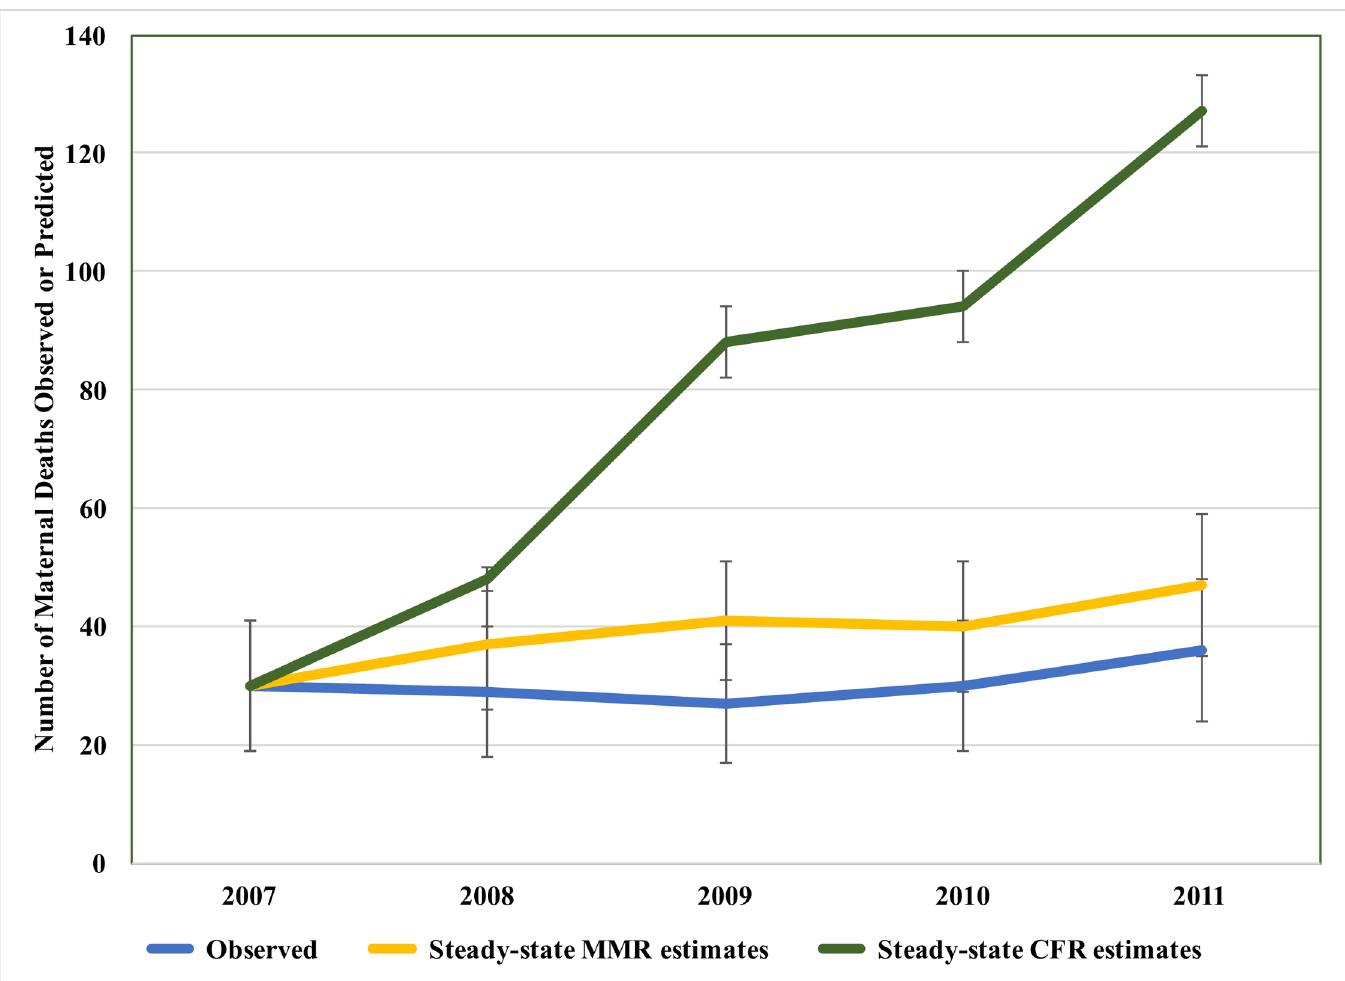
Fig 2. Maternal deaths predicted to have occurred by assumption. MMR, maternalmortality ratio (maternal deaths per 100,000live births); CFR, case- fatality rate.